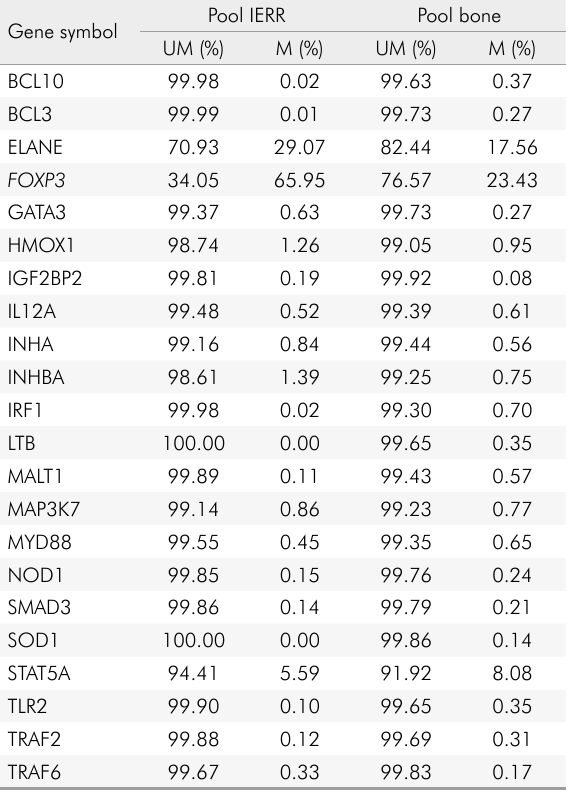
Table 4. Percentage of unmethylated (UM) and methylated (M) levels in immune response genes in pool IERR and pool